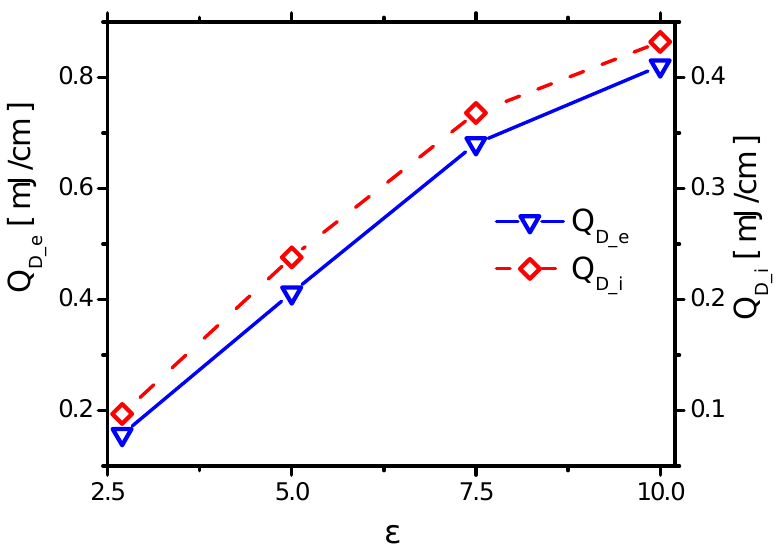
Figure 20. The effects of ε on the electrons’ energy Q D _ e and the ion’s energy Q D _ i in Case 1 to Case